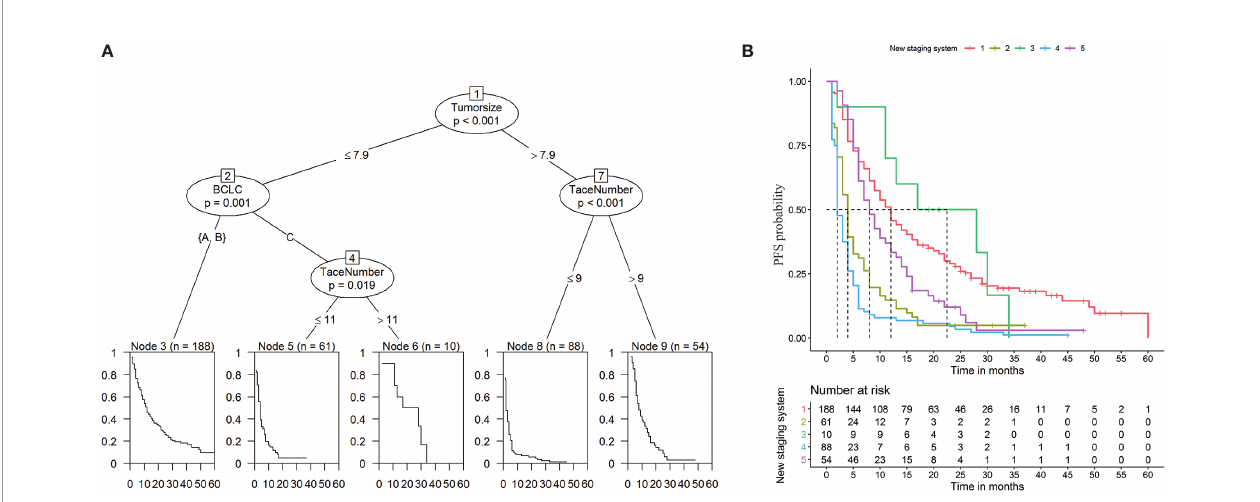
FIGURE 4 | Prediction of progression-free survival (PFS) (A) and Kaplan-Meier curves of PFS (B) based on decision tree